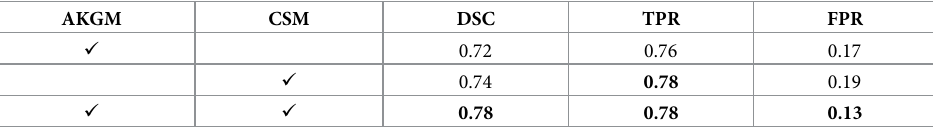
Table 6. Ablation study of fine segmentation unit in